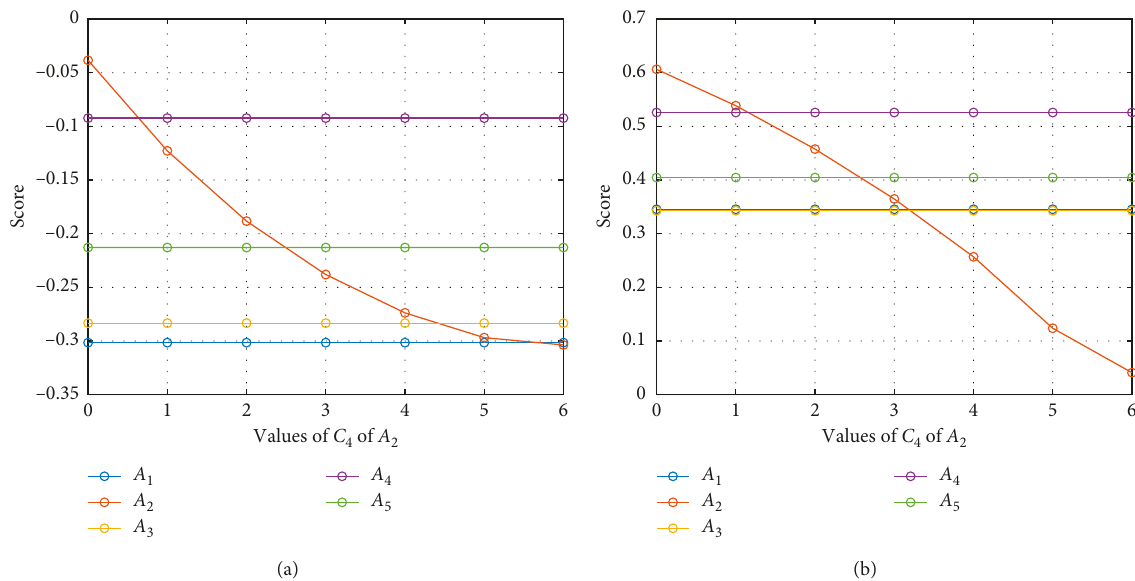
Figure 6: The change of the places of A 2 in the rankings of the group of WHMs [45] and the group of WGHMs [45]. Scores of the five companies computed by the group of (a) qROFWHMs and (b) qROFWGHMs.